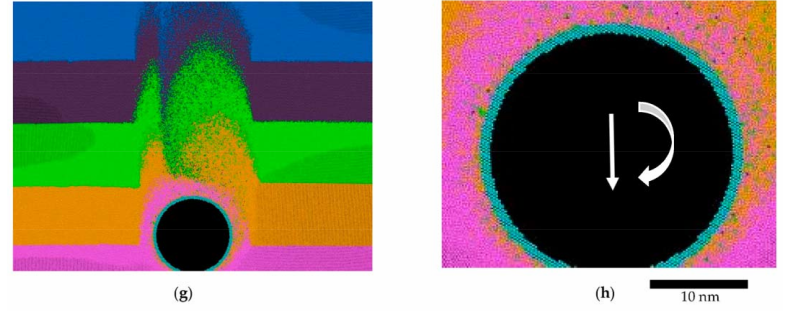
Figure 2. Atomic configurations after welding for ( a , b ) 0.01 (ps − 1 )/100 (m/s) (weld pitch of 8.3 × 10 0 and T max of 744 K) and ( c , d ) 0.01 (ps − 1 )/10 (m/s) (normalized weld pitch of 8.3 × 10 − 1 and T max of 938 K) ( e , f ) 0.1 (ps − 1 )/10 (m/s) at a mean temperature of 550 K (normalized weld pitch of 8.3 × 10 − 2 and T max of 1600 K) and ( g , h ) the same conditions ( a ) at a mean temperature of 650 K. White arrows indicate the advancing and rotating directions. The colors indicate the initial location of the atoms except black, which represents